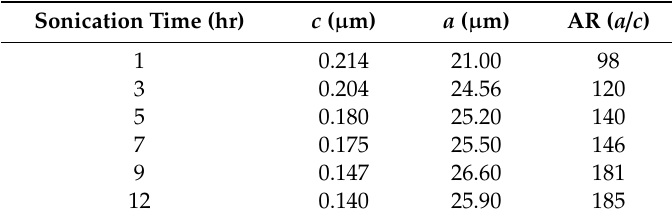
Table 5. a , c , aspect ratio (AR) values for sample M X1C3 ( d = 38 Å).